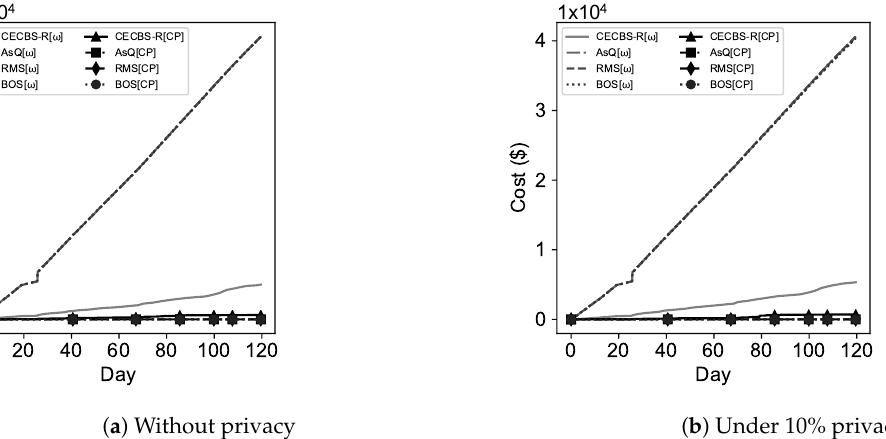
Figure 17. The accumulated edge ( ω ) and public cloud ( CP ) cost for ∼ 44.5 k jobs.